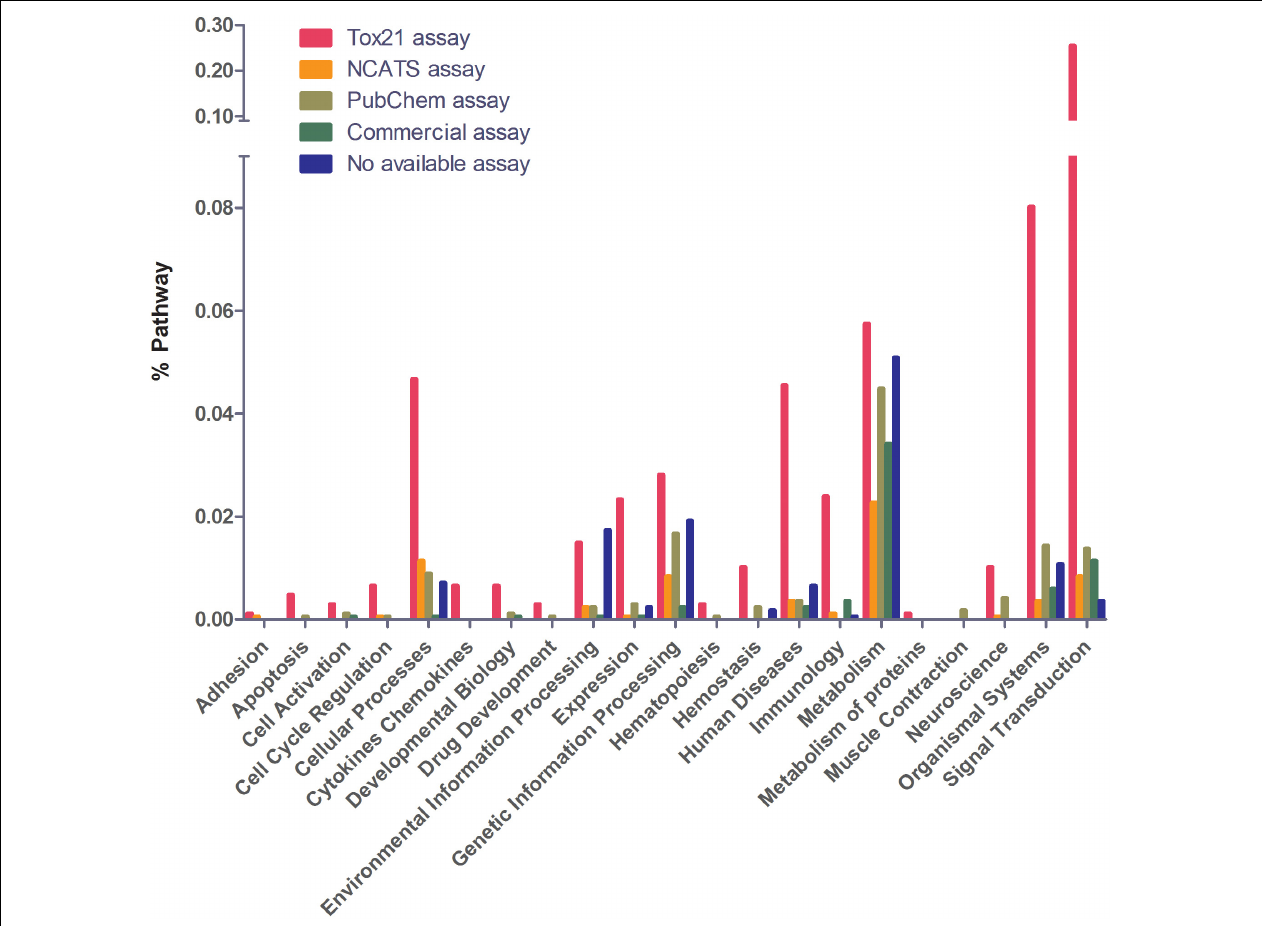
FIGURE 4 | Assay availability for different pathway categories. Cell signaling is the best covered category. Metabolism is the least covered category. Tox21 has the best coverage in human disease